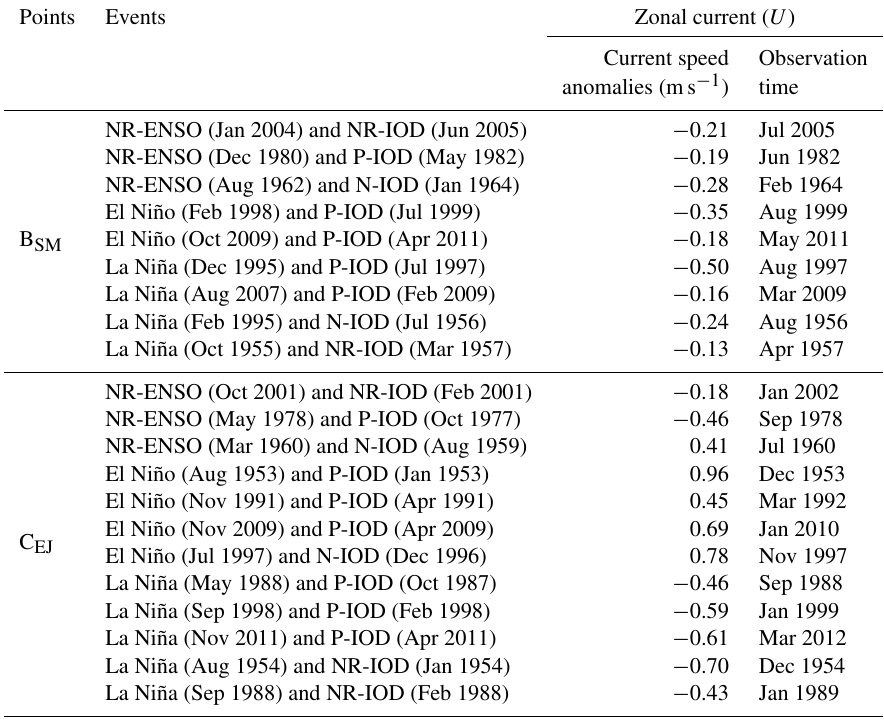
Table 6. Summary of major climate modes (ENSO and/or IOD) and the corresponding current anomalies through 1950–2013.